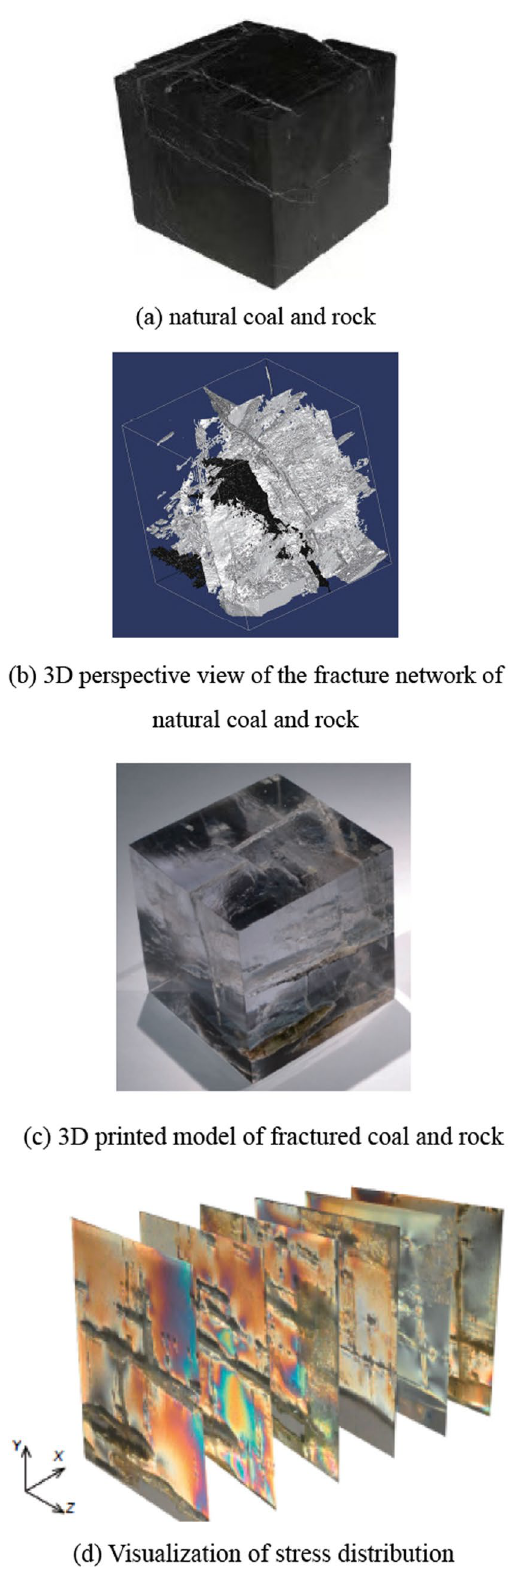
Fig. 10 3DP models with actual fracture network and visualization of stress distributions (Ju et al.